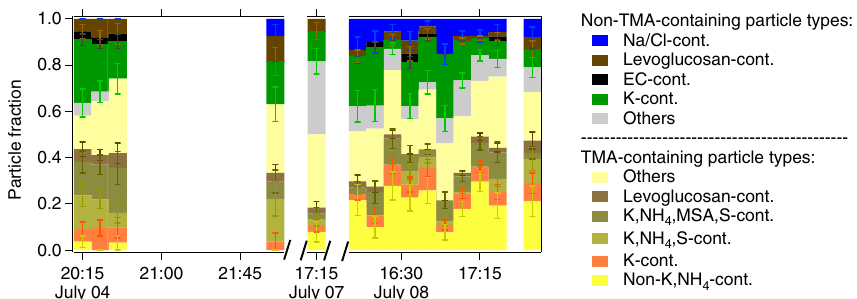
Figure 15. Temporally resolved aerosol composition of the identified non-TMA-containing particle types (normalized to the total num- ber of particles analyzed by the ALABAMA): Na / Cl-cont. (blue), EC-cont. (black), levoglucosan-cont. (brown), K-cont. (green) and “others” (gray) as well as TMA-containing particle sub-types (normalized to the total number of particles analyzed by the ALABAMA): “levoglucosan-cont.” (light brown), “K,NH 4 ,MSA,S-cont.” (dark green), “K,NH 4 ,S-cont.” (light green), “K-cont.” (orange), “Non-K,NH 4 - cont.” (yellow) and “others” (light yellow). Fractional abundances of the particle types were calculated for 10min time intervals. Only time intervals with at least 20 measured particles were considered. Measurements within the BL on 5, 10 and 12 July did not provide any 10min time interval with more than 20 spectra.